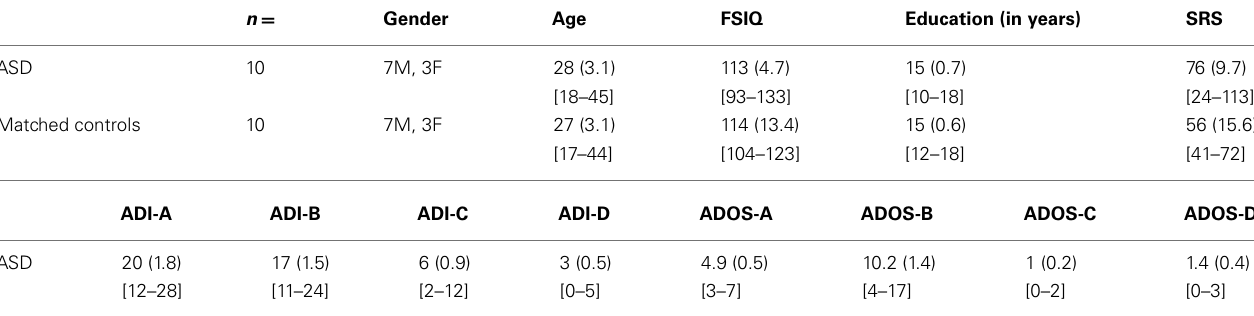
Table 1 | Demographics and assessment background of